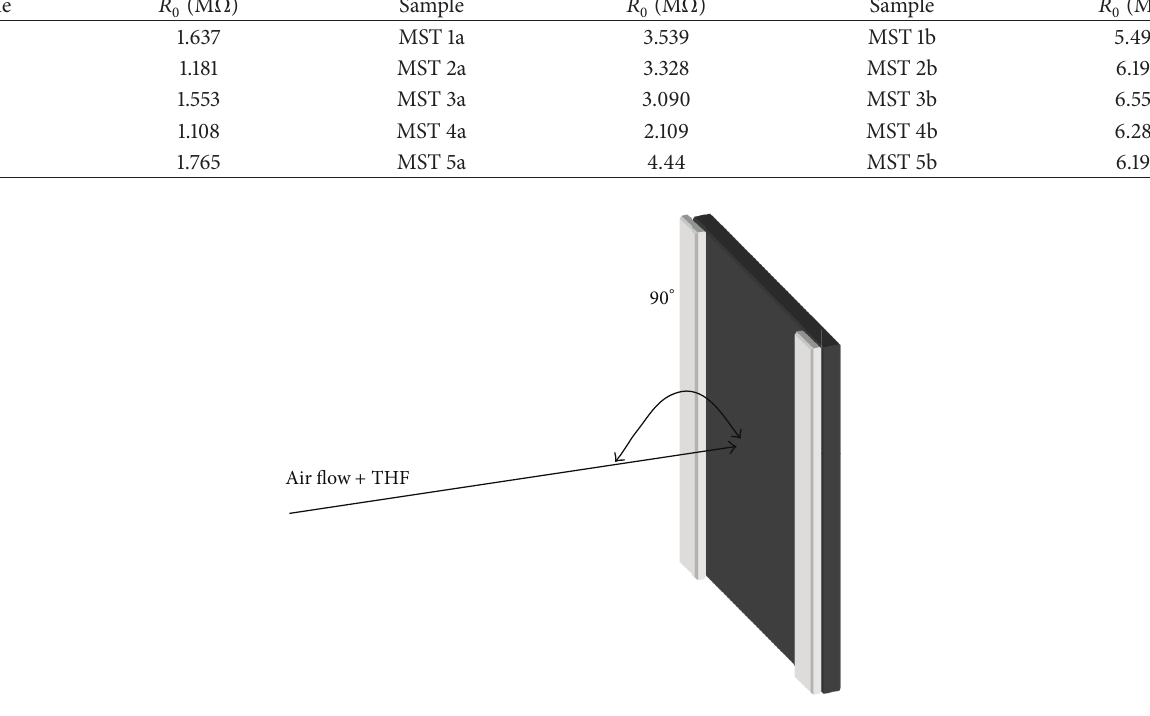
Figure 2: Experimental arrangement for sensing test.